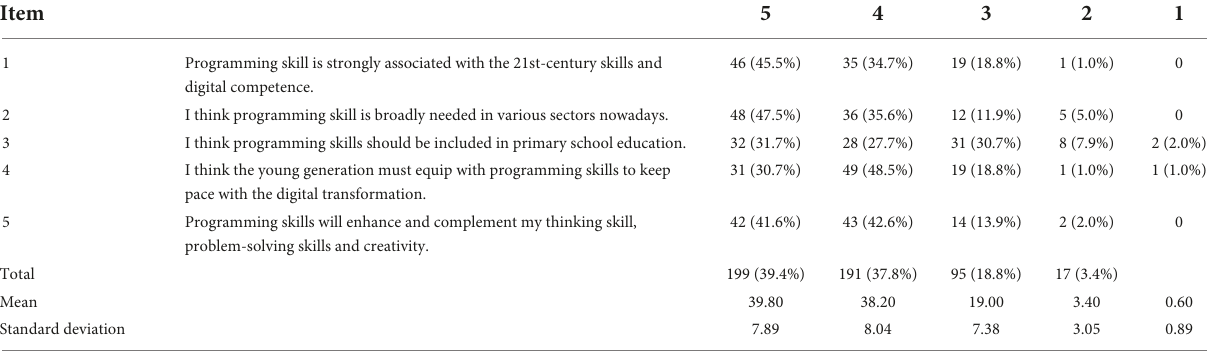
TABLE 3 Programming skill.